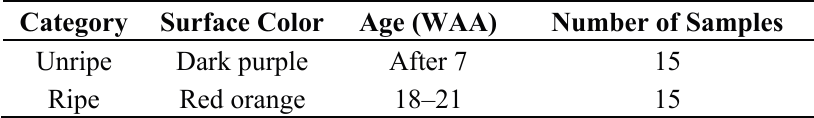
Table 3. Characteristics of selected